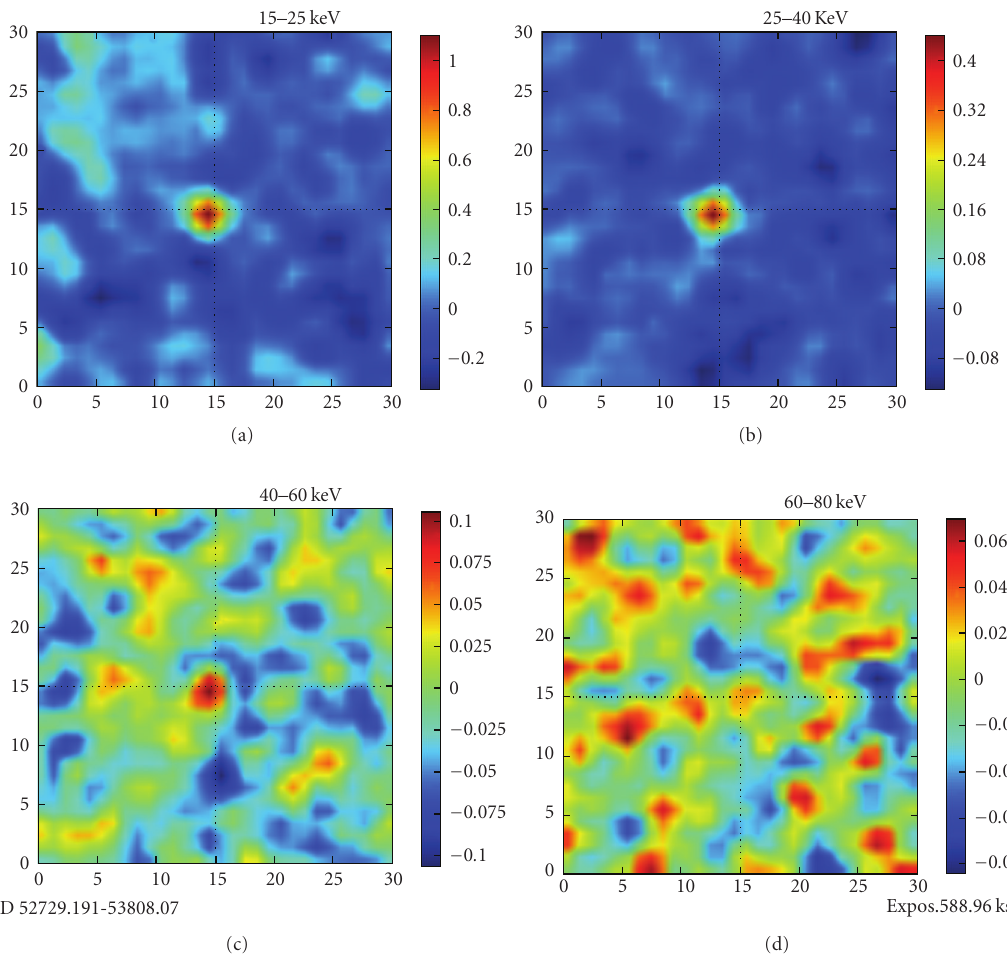
Figure 2: V1223 Sgr recent IBIS mosaics (coadded frames) all data (589 ks) intensity maps. The object is in the centre of the images.